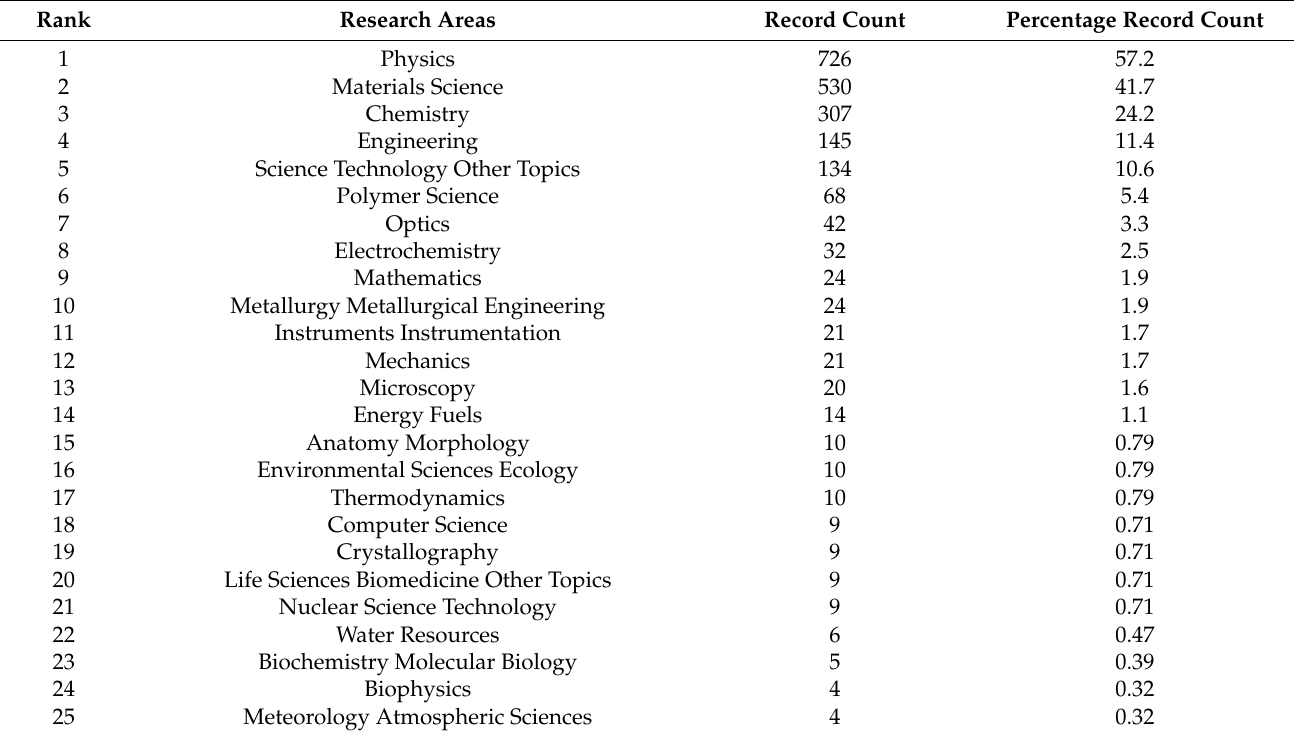
Table 5. Top twenty-five Web of Science research areas on fractal theory of thin